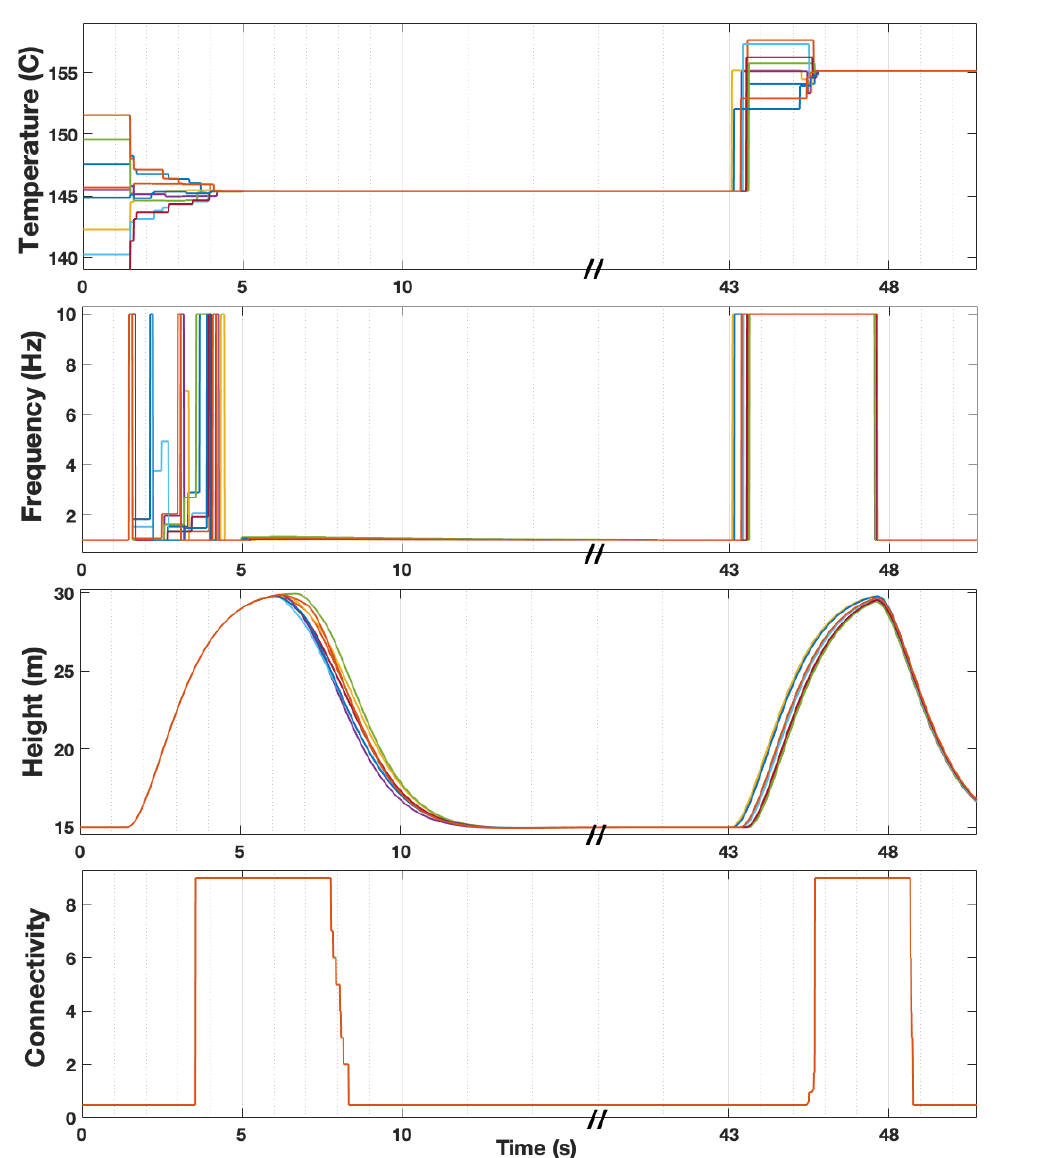
Figure 2. Behavior of the co-regulated